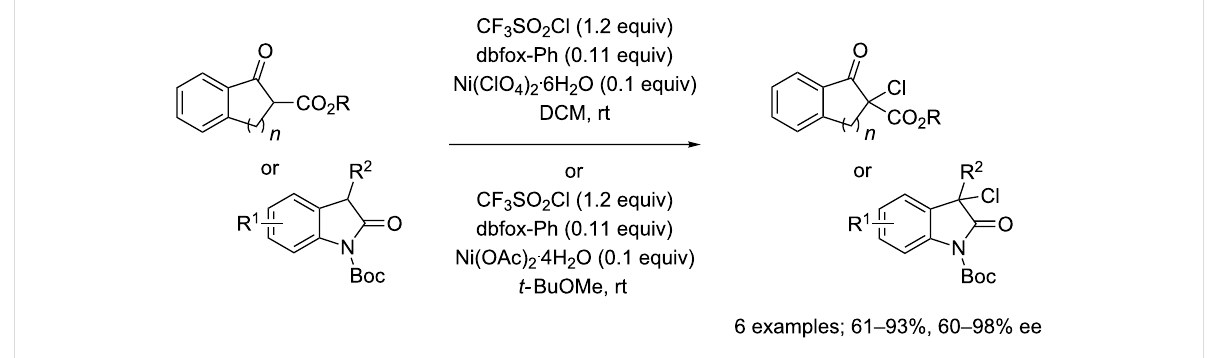
Scheme 42: Enantioselective chlorination of β -ketoesters and oxindoles.